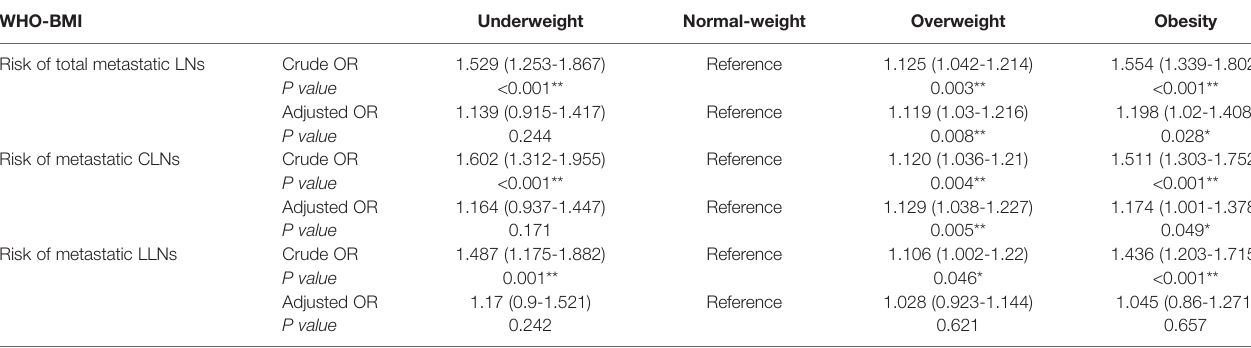
BMI, body mass index; OR, odds ratio; CI, con fi dence interval; LN +, lymph node metastasis; CLN, central lymph node; LLN, lateral lymph node. Age, lgFT3, lgTPO-Ab, tumor diameter >1cm, multifocality, High T stage and extrathyroidal extension as covariates to adjust OR value. *P < 0.05, **P < 0.01.